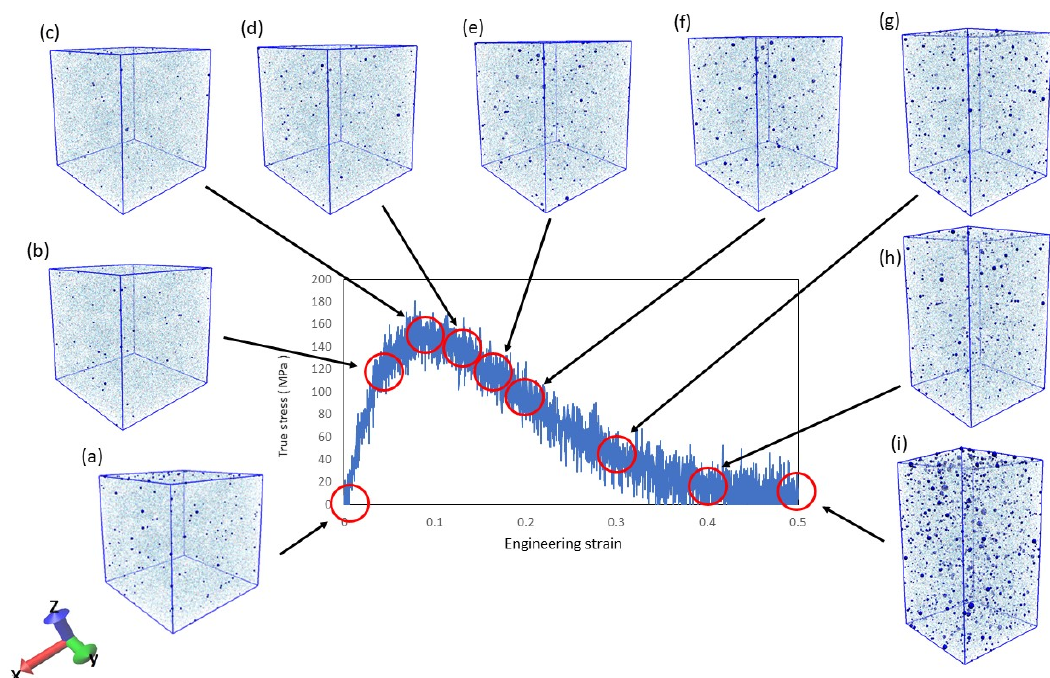
Figure 2. Stress–strain relationship with void increase due to fracture progression. (a–i) corresponds to the illustration of the voids in Figure 3.